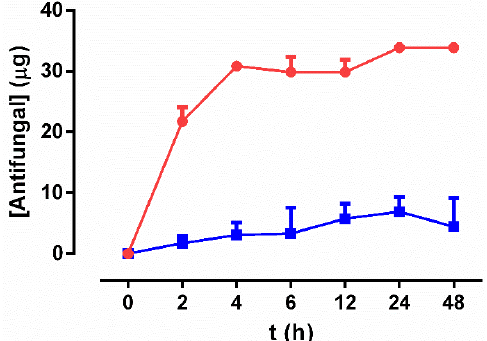
Figure 2. Kinetics of fluconazole ( red ) and anidulafungin ( blue ) released from F100 and A100 sol–gels over time. Data represent median and interquartile range of the amount of drug (in μg) measured in three replicates.